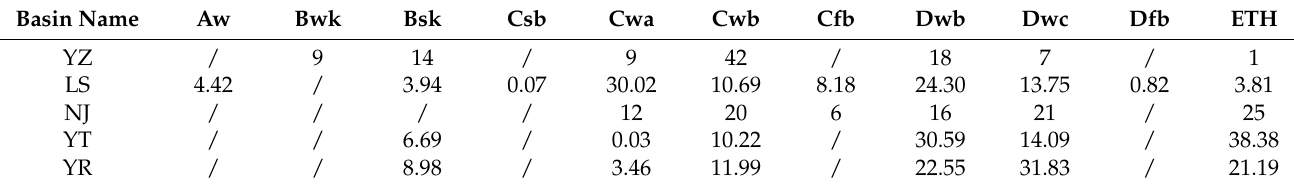
Figure 2. Climate division of southwest China. Table 4. Climate divisions in the five main river basins of southwest China.